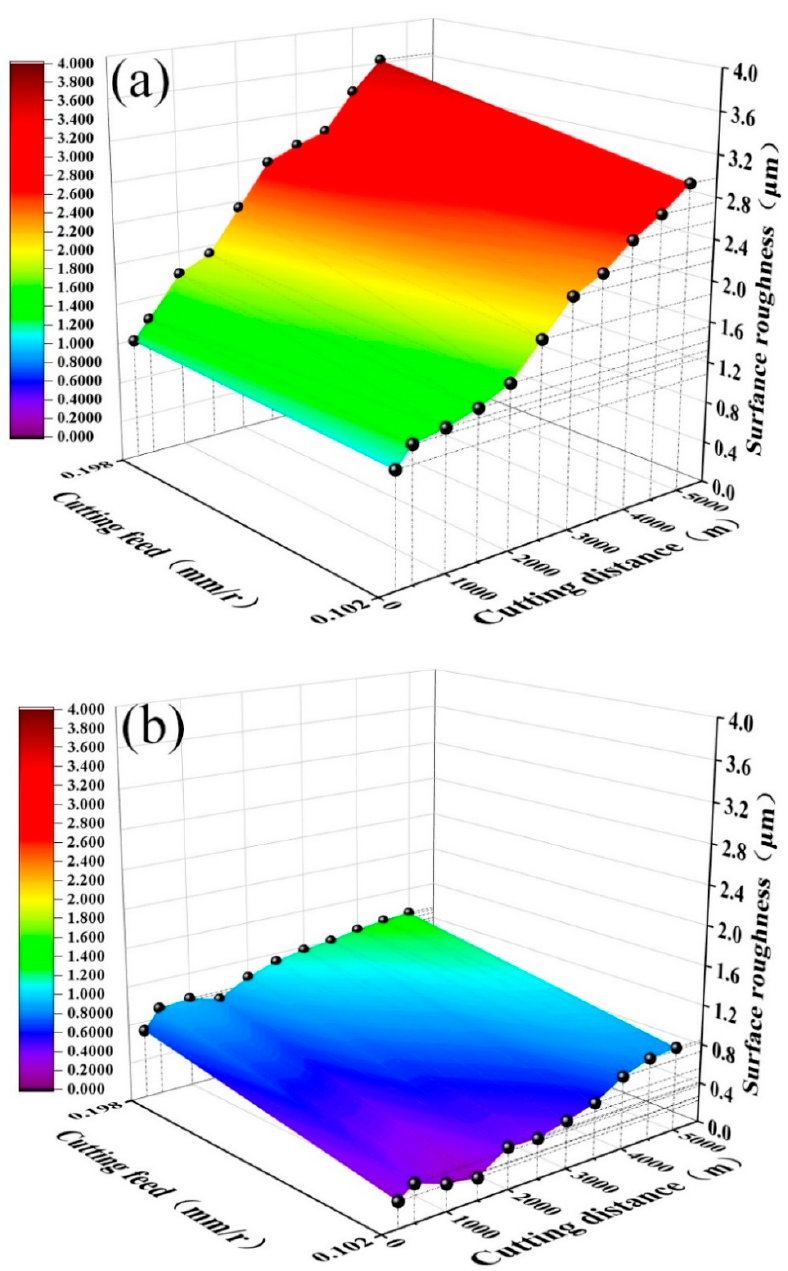
Figure 7. Workpiece surface roughness R a against cutting distance S under different cutting feed rates: ( a ) ATS, ( b ) ATSC10.